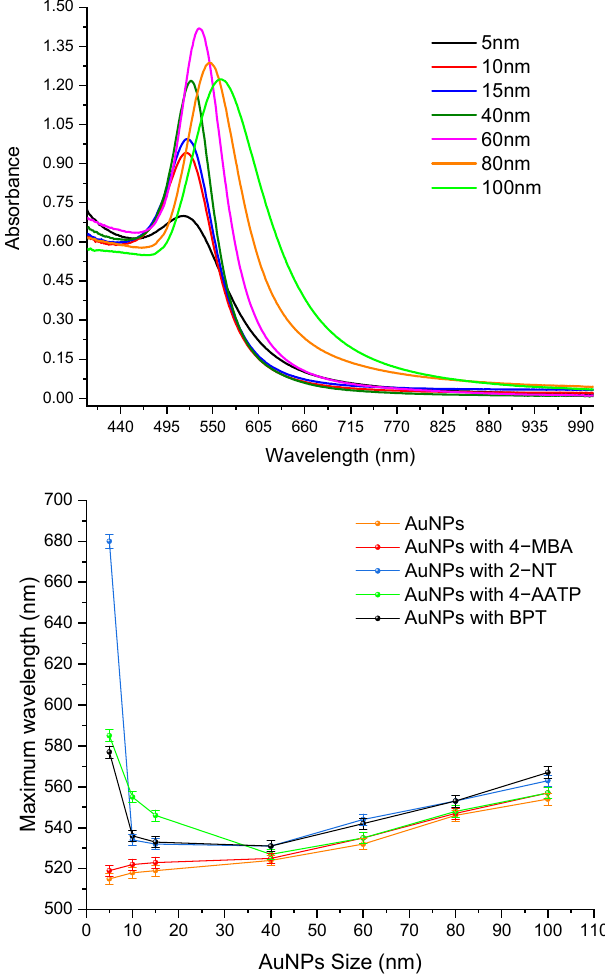
Figure 3. ( a ) UV-visible absorbance spectra of colloidal AuNPs of different sizes ranging between 5 nm and 100 nm. ( b ) The localized surface plasmon resonance maximum wavelength vs. AuNP size plot for all the solutions.